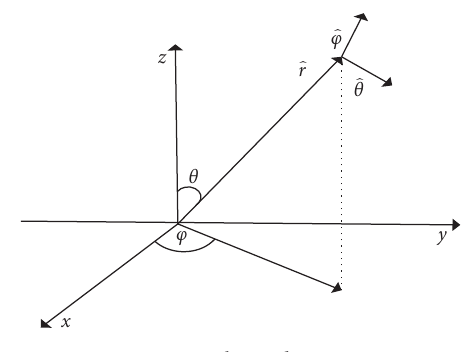
Figure 2: Spatial coordinate system.